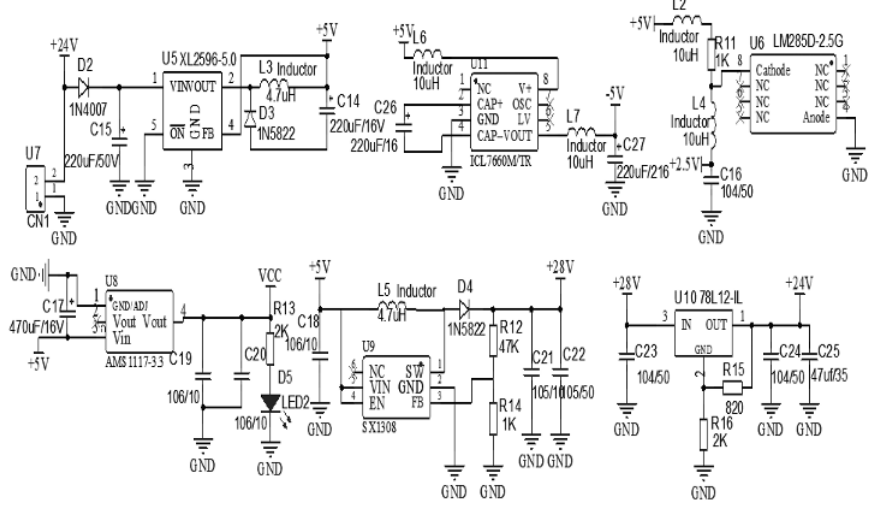
Fig. 3. Power module